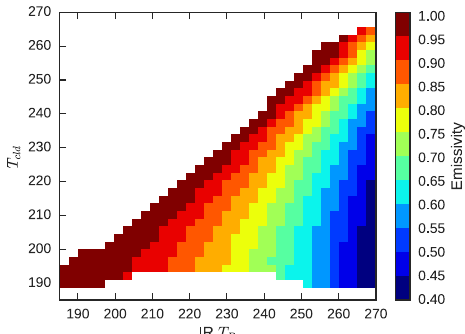
Figure 2. Average value of cloud emissivity for bins of T cld and T B for high clouds ( p cld < 440hPa) identified from AIRS observations in the tropics, at a spatial resolution of 0.5 ◦ (statistics for January and July 2006–2007).